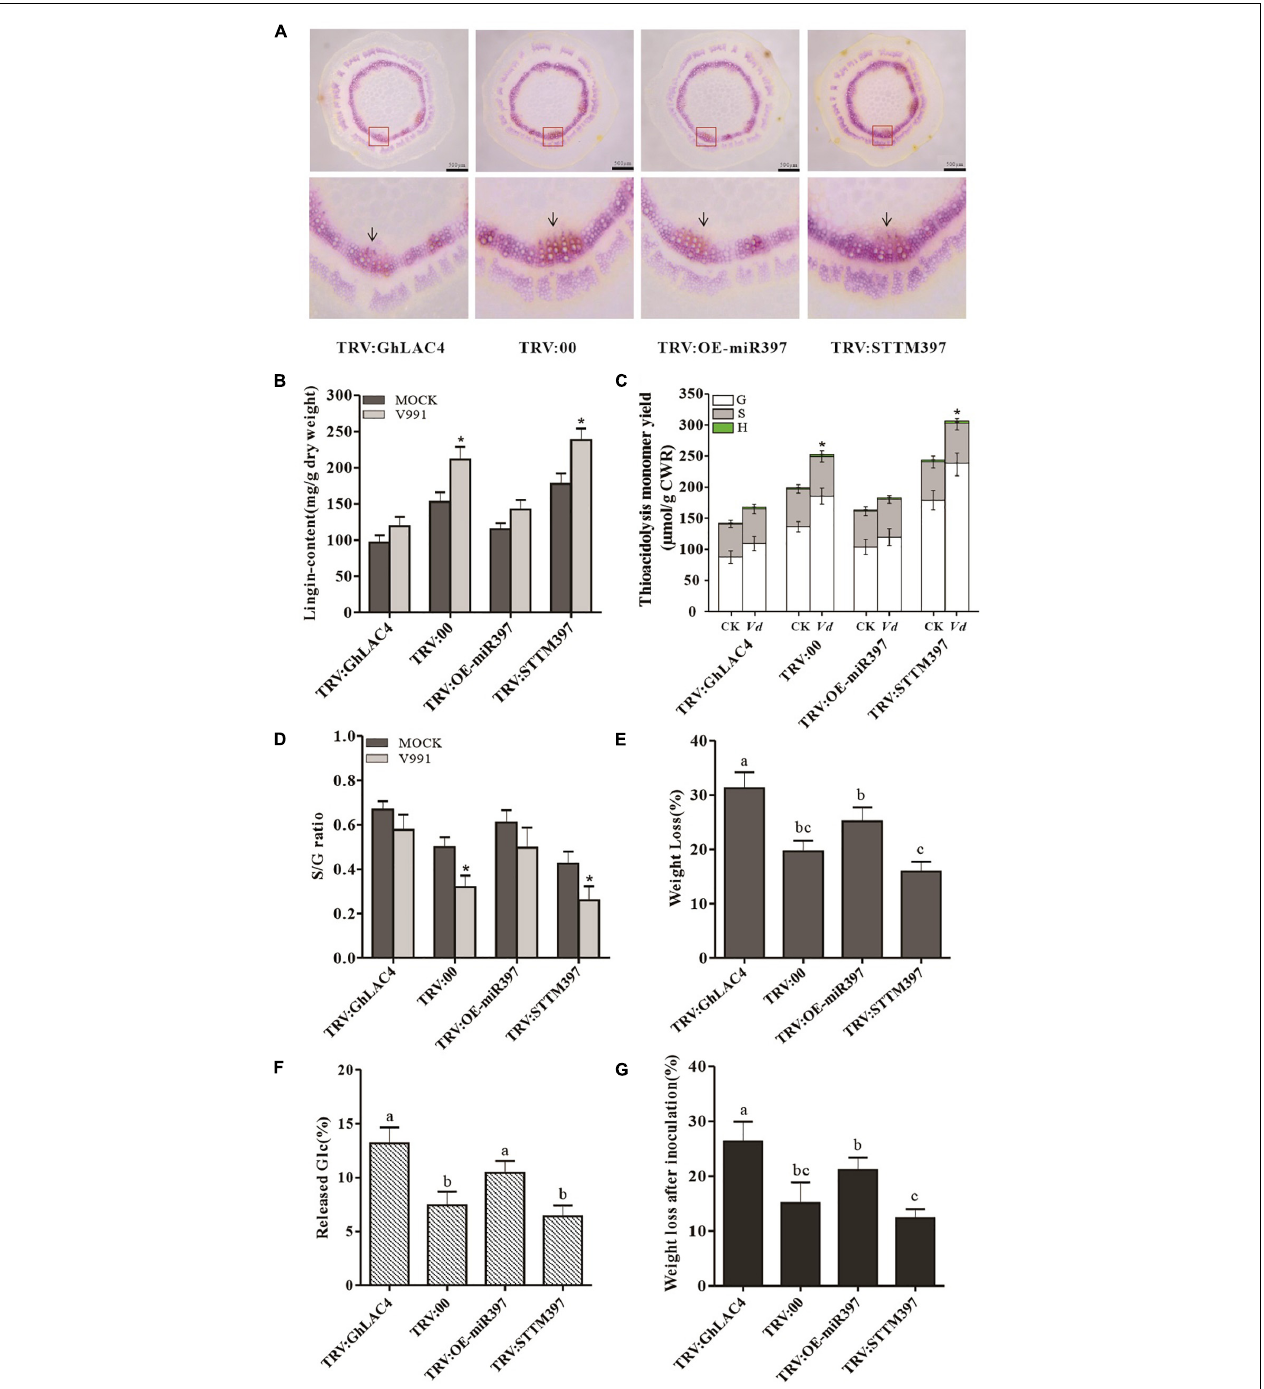
FIGURE 7 | Analysis of defence-induced lignin under V. dahliae infection and lignin protection to cell wall degradation. (A) Phloroglucinol-HCL staining of stem cross slices in TRV:STTM397, TRV:OE-miR397, TRV:GhLAC4, and the control plants inoculated with V. dahliae . (B) The Klason lignin content of in TRV:STTM397, TRV:OE-miR397, TRV:GhLAC4, and the control plants inoculated with V. dahliae . (C) Determination of the main H, G, and S thioacidolysis monomers released by the lignins of extract-free mature stems of laccase in TRV:STTM397, TRV:OE-miR397, TRV:GhLAC4, and the control plants. (D) S/G molar ratio in in TRV:STTM397, TRV:OE-miR397, TRV:GhLAC4, and the control plants. (E) Weight loss of extract-free stems digested by cellulose in TRV:STTM397, TRV:OE-miR397, TRV:GhLAC4, and the control plants. (F) Glucose (Glc) released in reaction solution of extract-free stems digested by cellulose in TRV:STTM397, TRV:OE-miR397, TRV:GhLAC4, and the control plants. (G) Weight loss extract-free stems digested by cellulase digested by V. dahliae secretion in TRV:STTM397, TRV:OE-miR397, TRV:GhLAC4, and the control plants. Scale bars in (A) is 500 µ m. Mean with SD comes from triple repeats experiments. Significant differences in (B–D) were determined using Student’s t -test (* P < 0.05). Different letters in (E–G) indicate significant difference ( P < 0.05) based on Tukey’s HSD test.